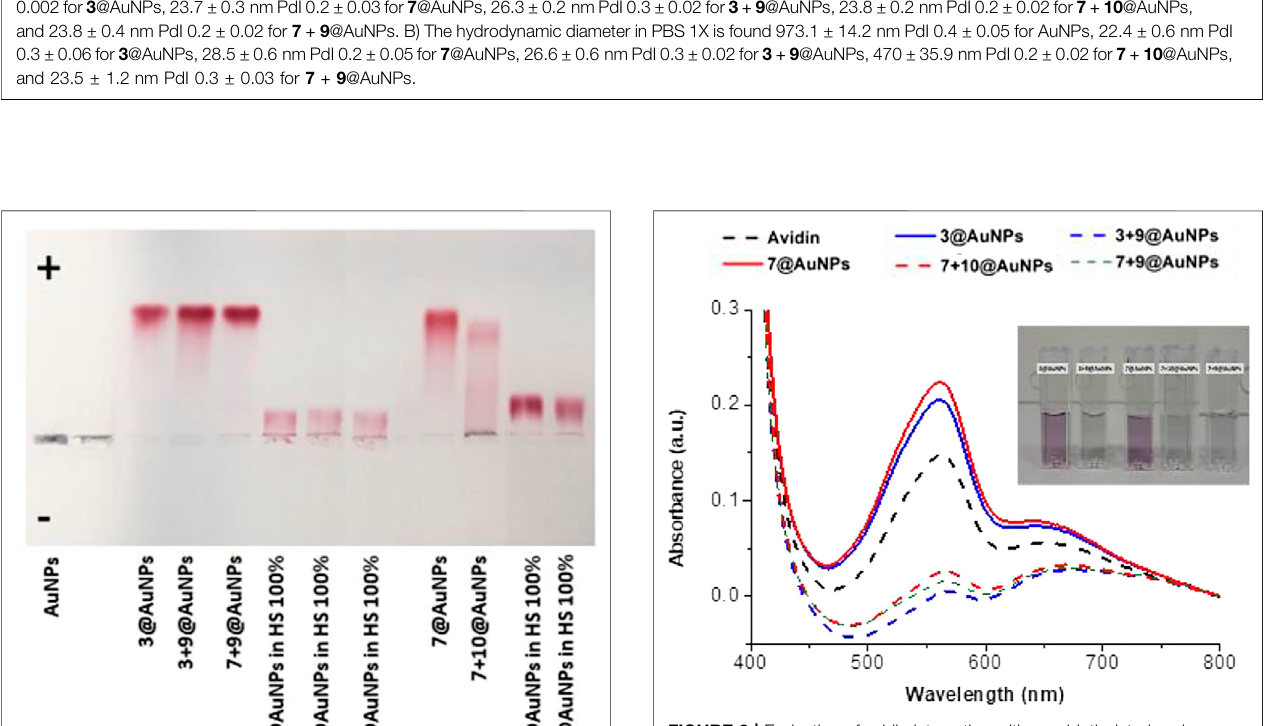
Frontiers in Chemistry |